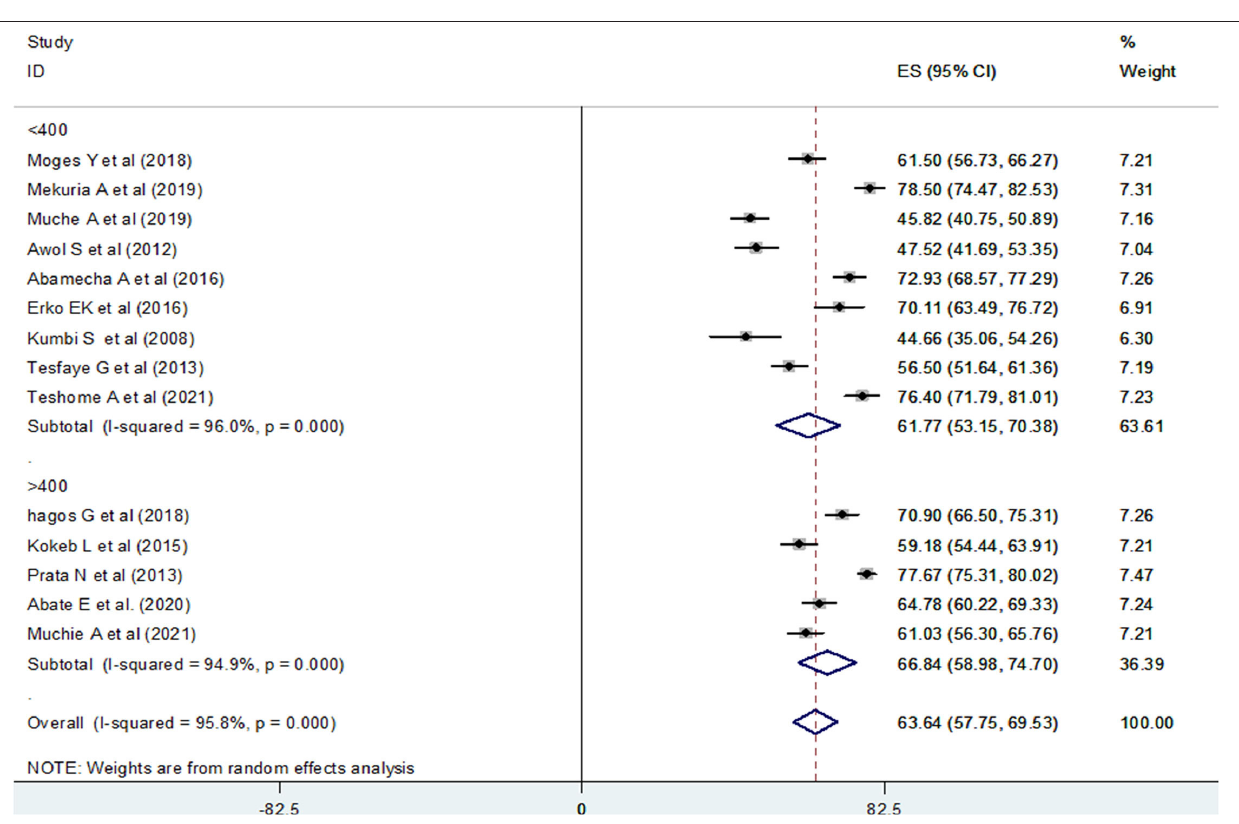
FIGURE 6 | Forest plot of the prevalence of PAFP with corresponding 95% CIs of the subgroup analysis based on the total sample size of studies in